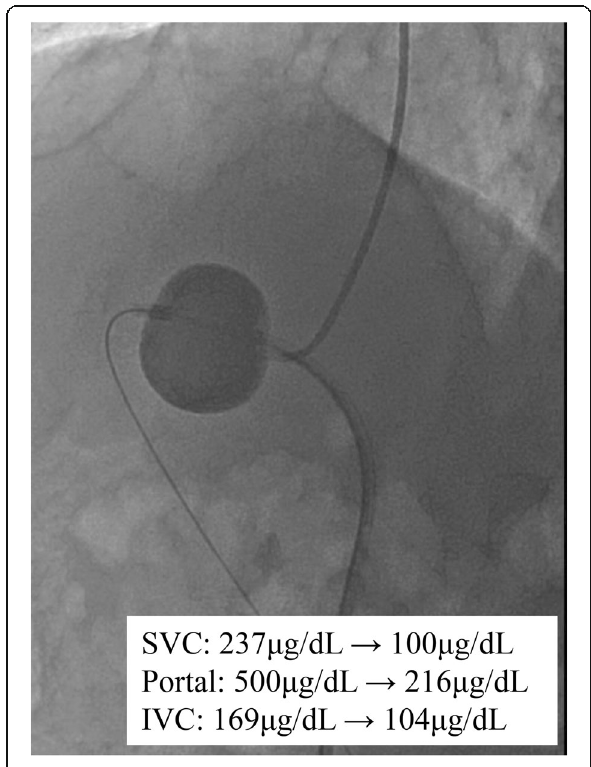
Fig. 2 Temporary balloon occlusion testing was performed for 3 h. The laboratory test following temporary BOT shows decreased serum ammonia levels in SVC, portal vein, and